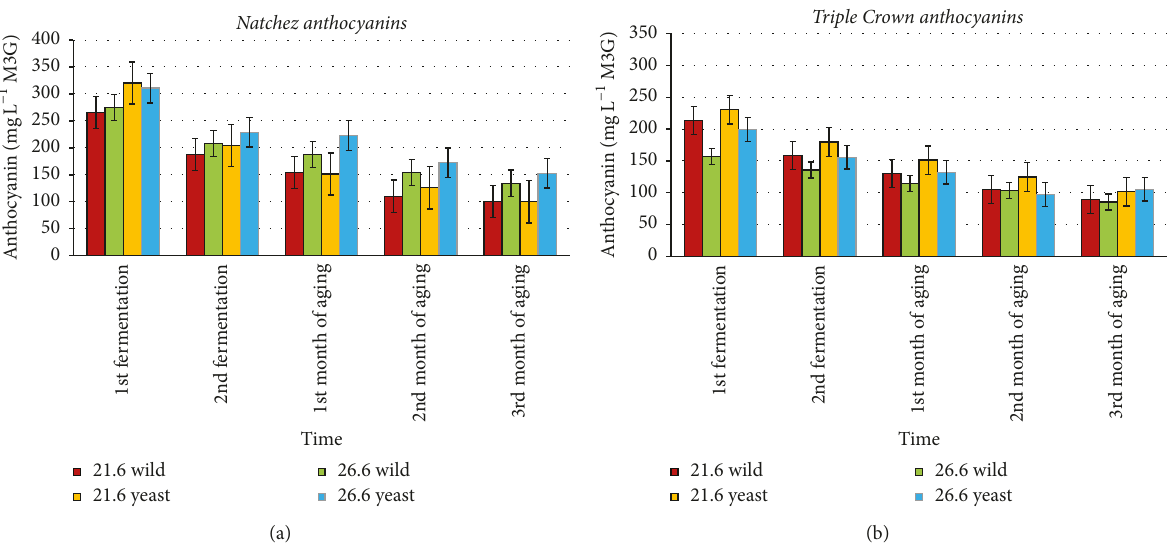
Figure 3: Total anthocyanin concentrations ( 𝑁 = 120 ) of “Natchez” blackberry (a) and “Triple Crown” blackberry (b) fermented juices and wines. Error bars represent ± standard deviation of the mean ( 𝑛 = 2